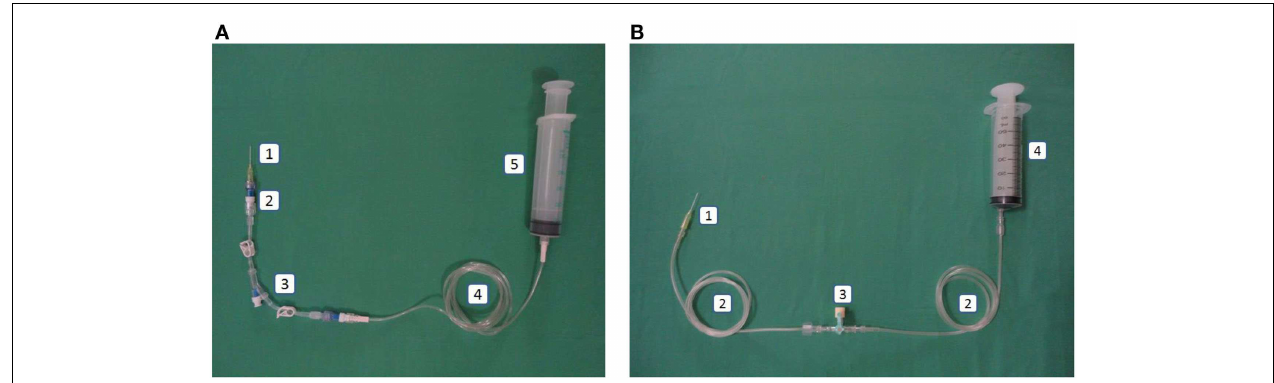
FIGURE 1 | (A) Intervention: peripheral line in the closed catheter access system. 1. Intravascular cannula, 2. Single needleless connector, 3. Double lumen NCs with luer lock, 4. Extension tube luer lock, 5. Luer lock syringe. (B) Control: peripheral line in the open system. 1. Intravascular cannula, 2. Extension tube slip tip, 3.Three-way stopcock, 4. Slip tip syringe.